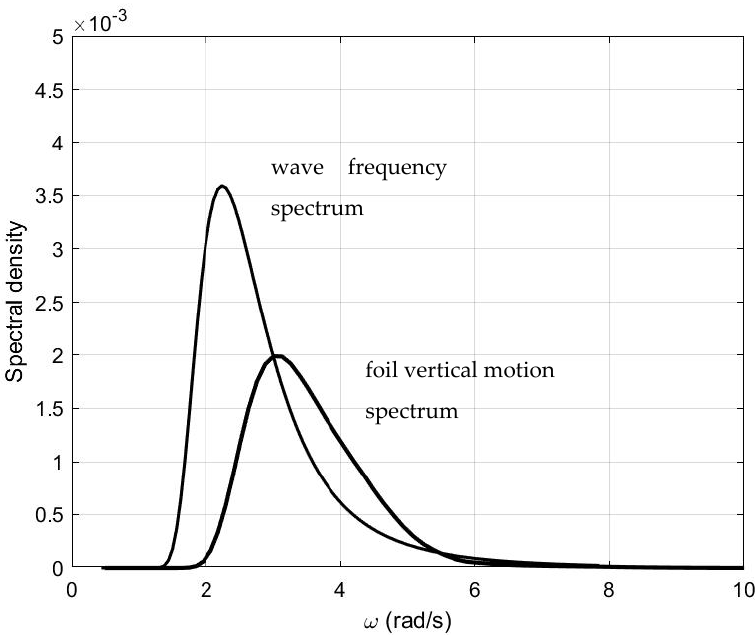
Figure 10. Sea spectrum ( H s /L = 0.03 and T p U / L = 0.7) for head seas ( β = 180 ◦ ), normalized with respect to the peak value of the incident wave spectrum S max and foil’s vertical motion spectrum of the foil S .